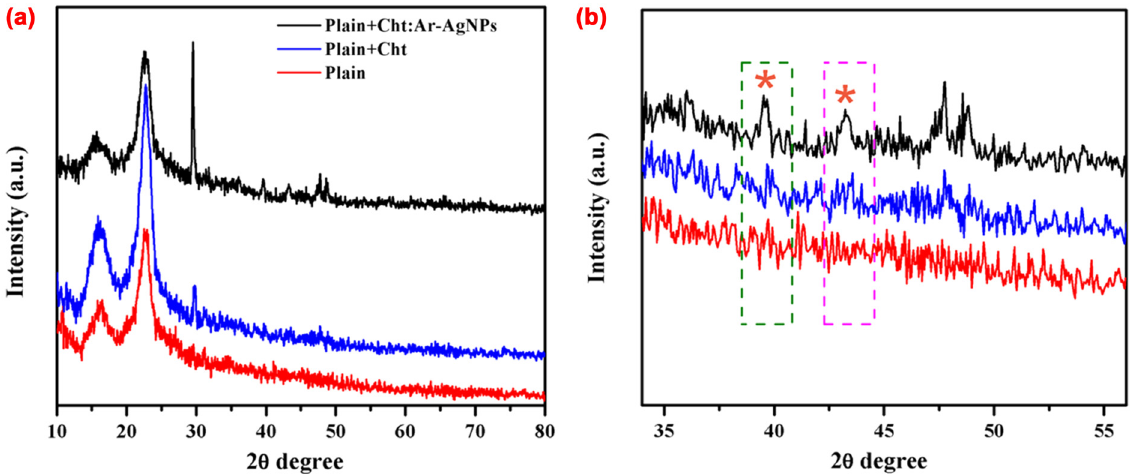
Figure 4: ( a ) XRD pattern of plain paper, chitosan - coated paper, and chitosan with agar - mediated AgNPs - coated paper; ( b ) asterisk symbol exhibited AgNPs peak at 2 θ values.